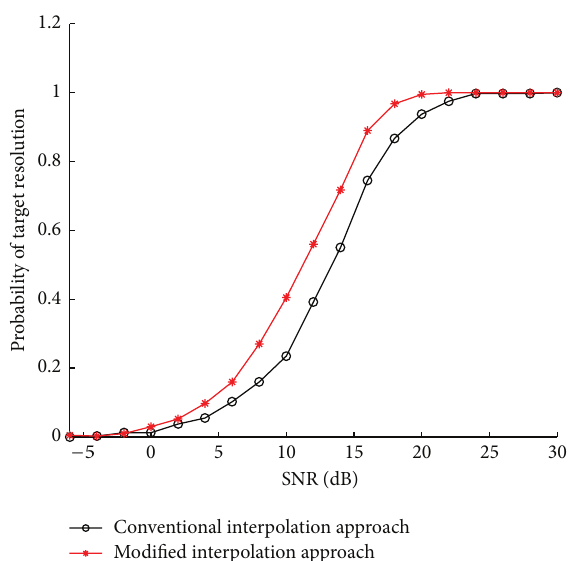
Figure 7: Probability of target resolution versus SNR.